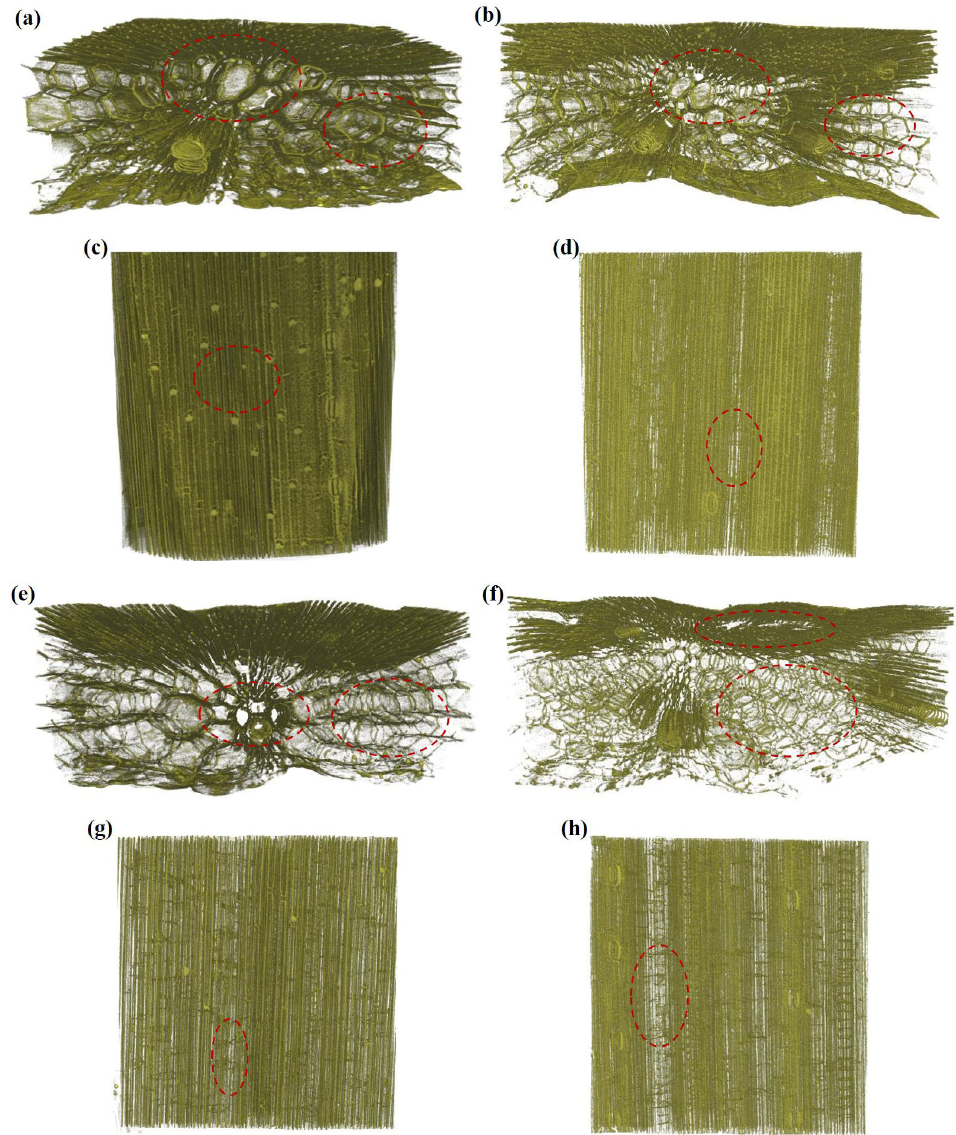
Figure 7. Micro-CT images of wheat straw: ( a , c ) no bio-enzyme pretreatment; ( b , d ) lipase pretreat- ment; ( e , g ) xylanase pretreatment; ( f , h ) lipase and xylanase compound enzyme treatment.